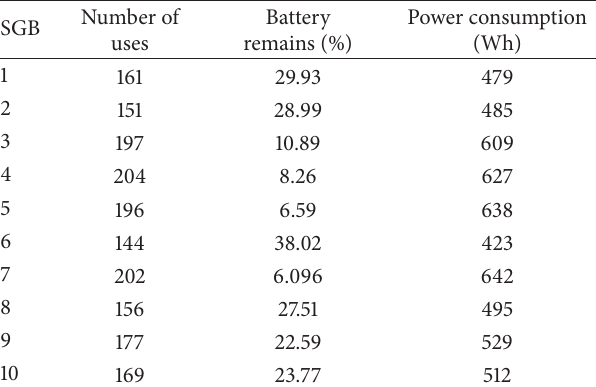
Figure 12: Comparison of average power consumption per use in Groups A and B. Table 3: Experimental results of Group A.